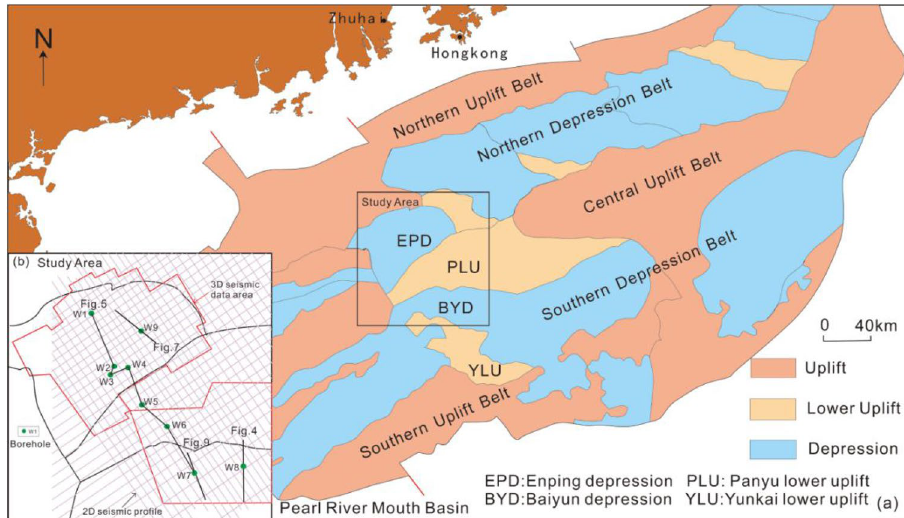
Figure 1. ( a ) Distribution and tectonic unit division of the Pearl River Mouth Basin (modified from Lin et al. 2017), ( b ) location of figures and seismic and well logging data collection